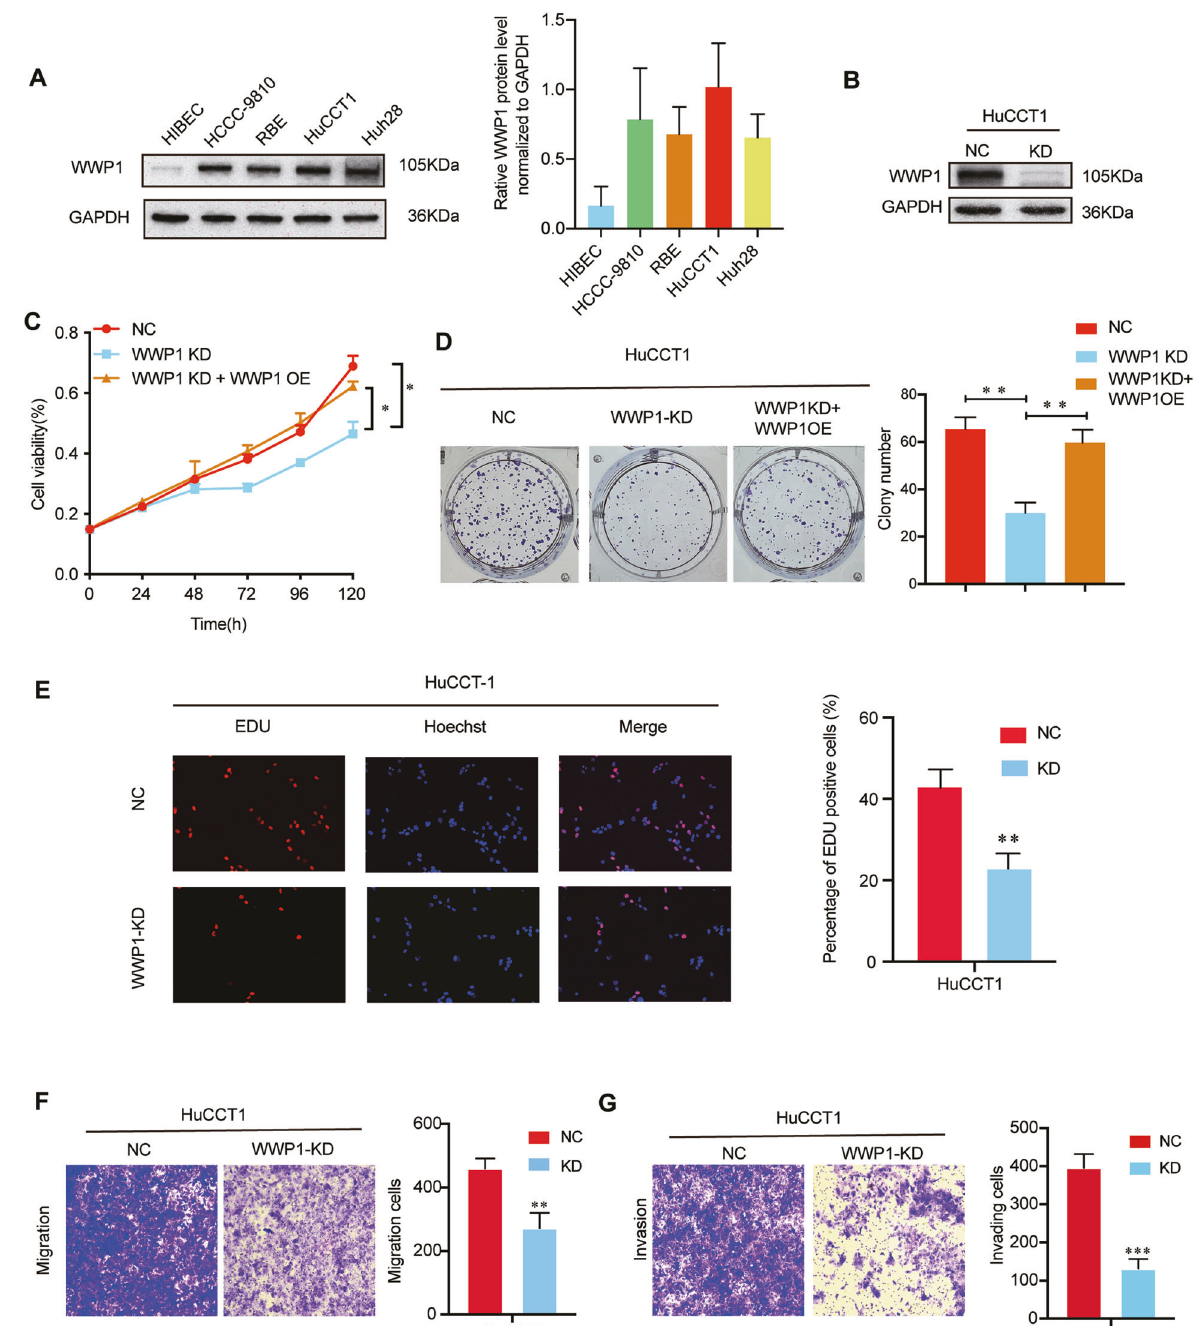
Fig. 2 WWP1 silencing suppressed proliferation, migration, and invasion of HuCCT1 cells in vitro. A WWP1 protein levels in the four ICC cell lines and normal human intrahepatic biliary epithelial cell (HIBEC) were determined by western blotting. B The ef fi ciency of WWP1 knockdown was estimated by western blotting. C CCK-8 assay, D colony formation assay, E EdU assay were performed to estimate the proliferation of HuCCT1 cells after WWP1 silencing, n = 3. Overexpression of WWP1 again in HuCCT1 cells infected with the lentiviral shWWP1 rescued the ability of proliferation ( C , D ). F , G Transwell assays were performed to detect the migration ( F ) and invasion ( G ) of HuCCT1 cells after WWP1 silencing, n = 3. ** P < 0.01, *** P < 0.001. staining and co-IP assays to detect the interaction between WWP1 Genomes (KEGG) analysis of these proteins were performed in Fig. and NDFIP1 in ICC cell lines. From the results, WWP1 was 6B, C, indicating that WWP1 might regulate fundamental cellular con fi rmed that interact with NDFIP1 in HuCCT1, HCCC-9810, and activities. Combined with the results of protein – protein interaction RBE cells (Fig. 6E, F). (PPI) network (Fig. 6D) with the obvious speci fi c band at a Moreover, we explored whether WWP1 in fl uenced the level of molecular weight of 26KDa in SDS-PAGE gel, NDFIP1 was of NDFIP1 via western blotting. As shown in Fig. 7A, depletion of interest because its PPxY motifs were predicted to directly bind to WWP1 led to an elevation in NDFIP protein level in HuCCT1cells, the WW domains of WWP1(Fig. 6A). Accordingly, we performed IF Cell Death Discovery (2022)